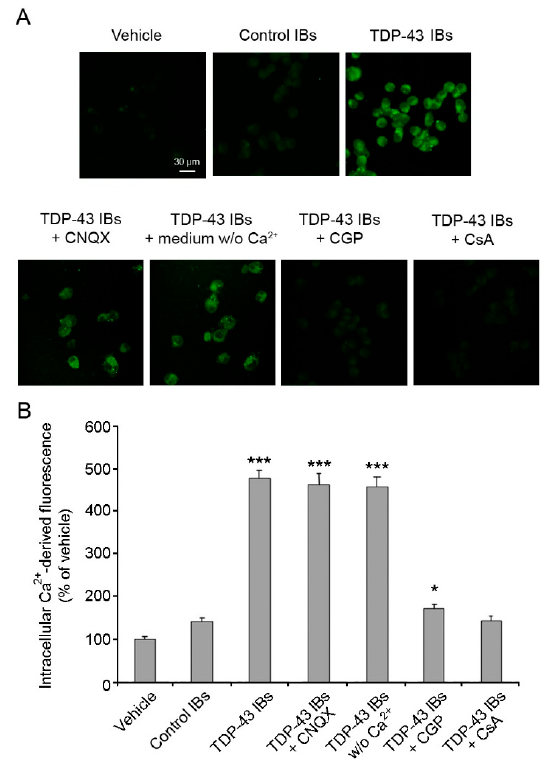
Figure 2. Analysis of intracellular Ca 2+ levels. ( A ) Representative confocal scanning microscope images of N2A cells showing intracellular Ca 2+ levels after transfection with vehicle, control IBs, and TDP-43 IBs in the absence or presence of 5 μ M CNQX, 5 μ M CGP, or 10 μ M CsA or in medium without Ca 2+ . The green fluorescence arises from the intracellular Fluo4 probe bound to Ca 2+ . ( B ) Quantitative analysis of the green fluorescence arising from the Fluo4 probe. Error bars are S.D. * p < 0.05 and *** p < 0.001 relative to cells transfected with vehicle.